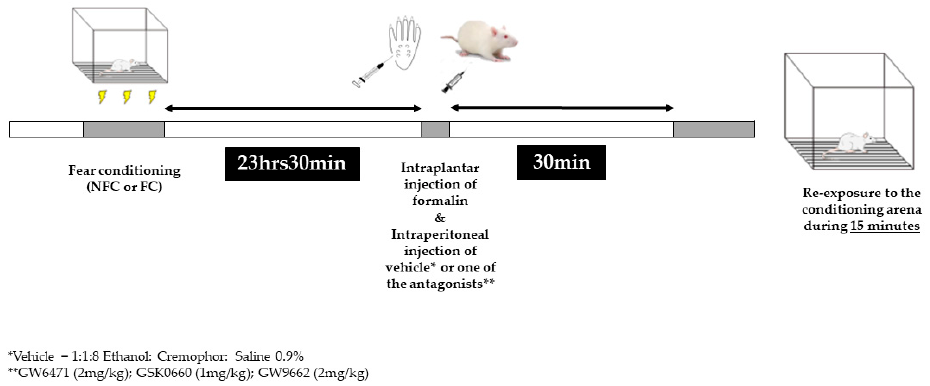
Figure 9. Graphical representation of the experimental